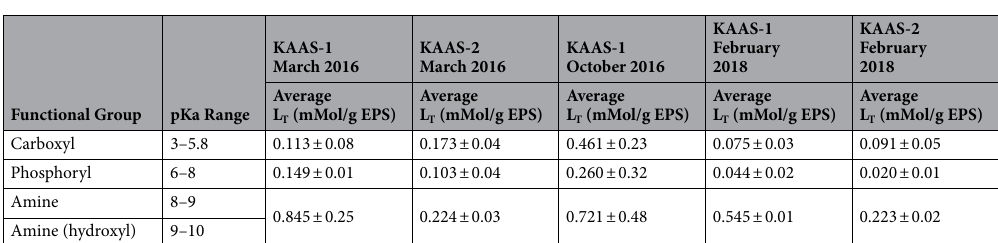
Table 1. Summary of Total functional group concentrations over their pKa ranges from the uppermost mat layers during each sampling season. These measurements originate from EPS extracted from the green and orange layers or top 0.5 cm of each mat given a particular sampling